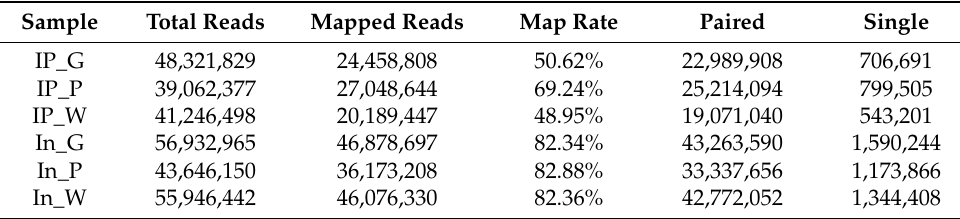
Table 2. Genome mapping of clean reads.